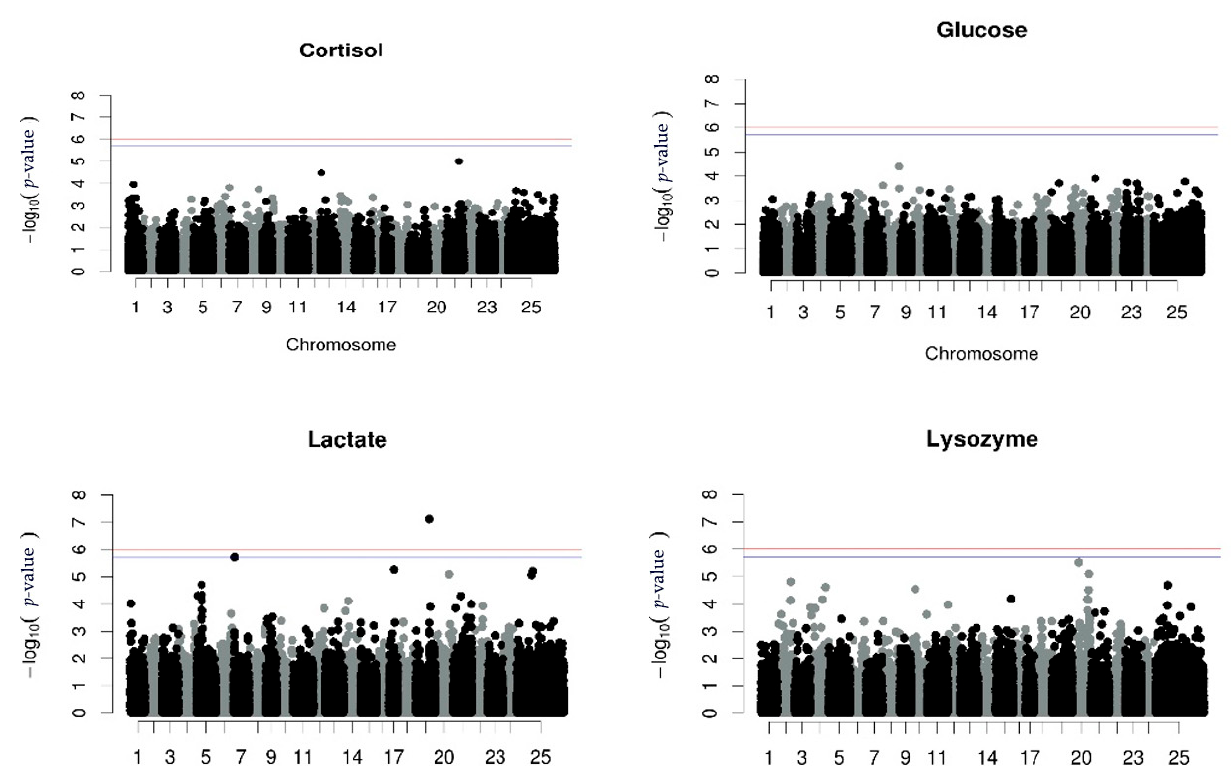
Figure 1. Manhattan plots per trait using GWAS with repeated measurements. The red (initial value 0.05) and the blue line (initial value 0.1) illustrate the threshold after Bonferroni correction (at the genomic level). Table 5. Significant SNPs in batch 10 and 13 from univariate and repeated GWAS.